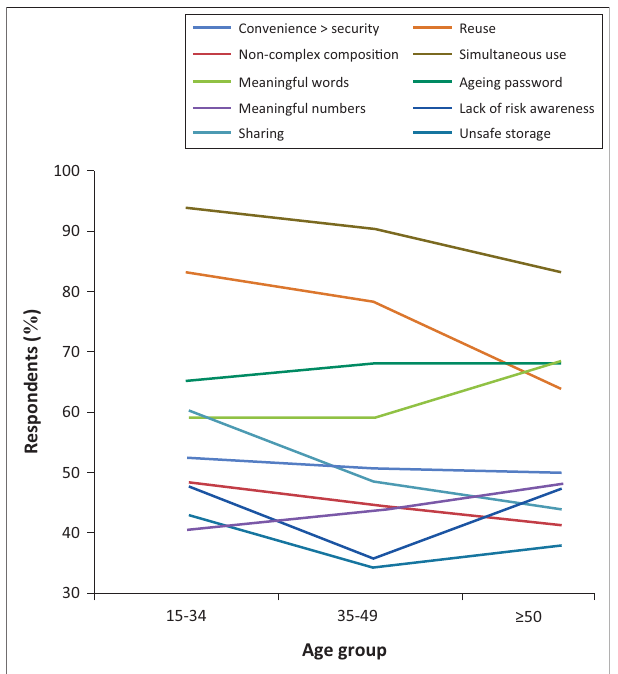
Figure 2 indicates the weak password practices per age group.